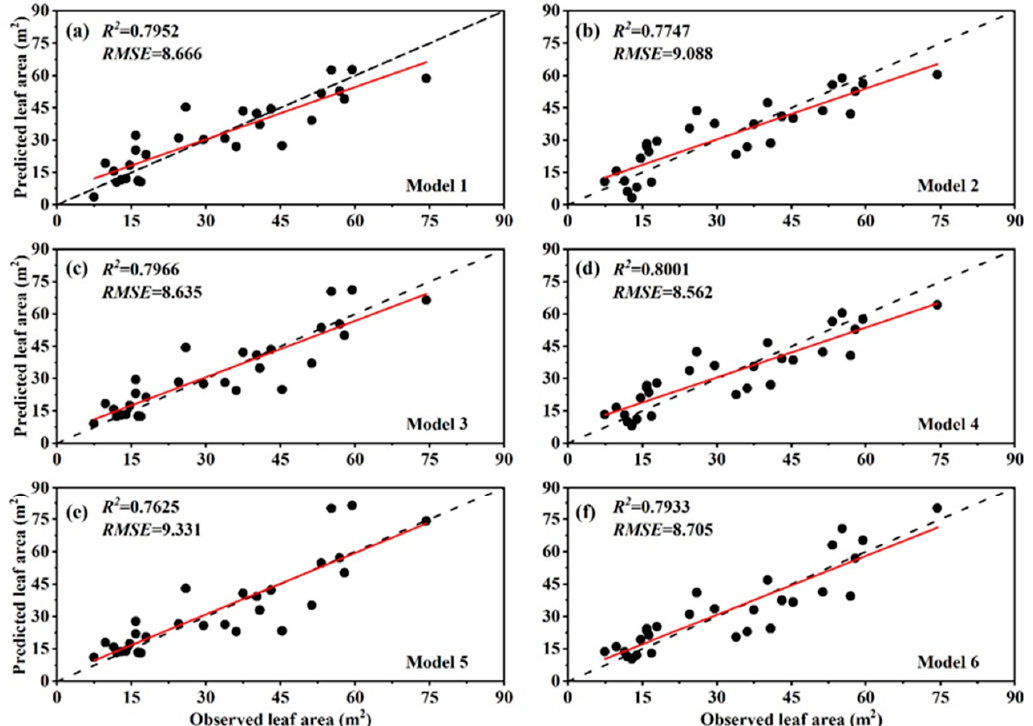
Figure 5. Validation of the LA allometric relationships based on leave-one-out cross validation (LOO). The red line represents the regression line between the observed and predicted LA . The black dashed line represents the 1:1 line. ( a ) Model 1: Linear regression using H ; ( b ) Model 2: Linear regression using DBH ; ( c ) Model 3: Exponential regression using H ; ( d ) Model 4: Exponential regression using DBH ; ( e ) Model 5: Logarithmic regression using H ; and ( f ) Model 6: Logarithmic regression using DBH